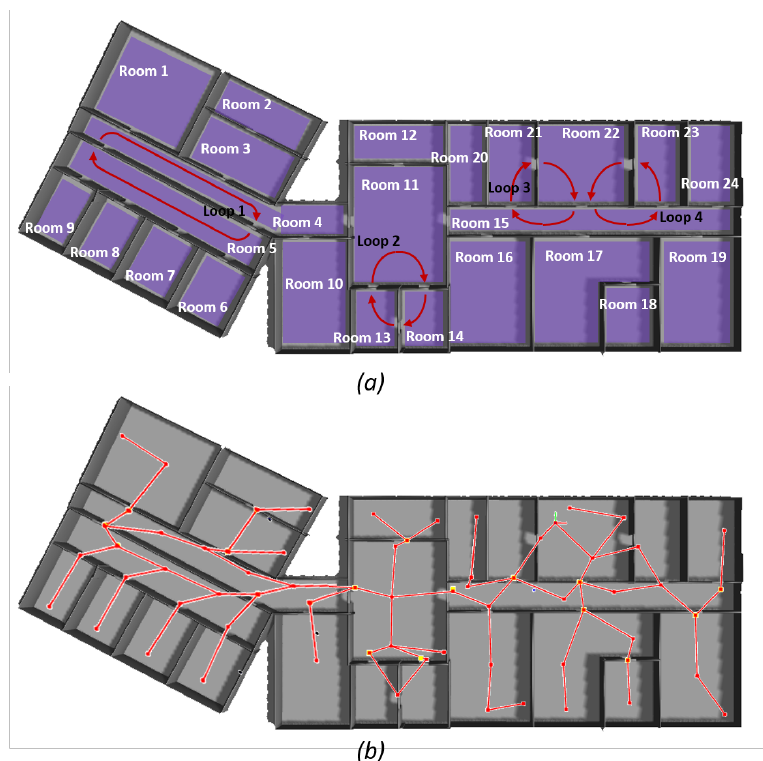
Figure 11. Results for the first big office simulated environment: ( a ) the environment and the different rooms and loops are indicated; ( b ) the resulting topological map. The topological map is layered on top of the simulated environment in order to facilitate reader’s comprehension.